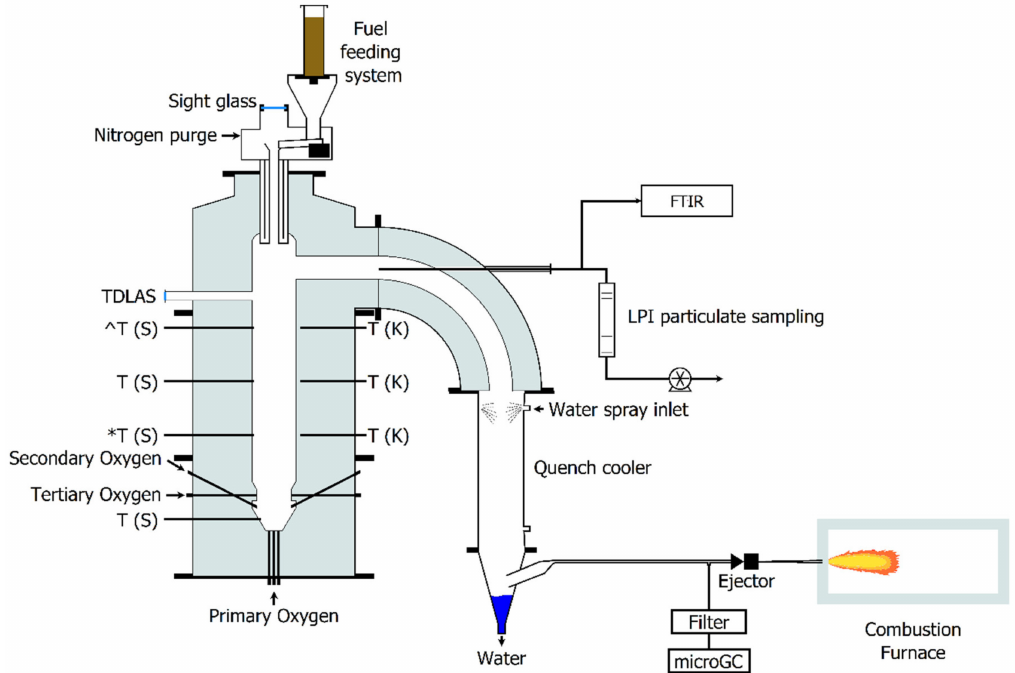
Figure 1. Schematic process flow diagram of the fixed-bed oxygen blown gasifier (FOXBG). For process temperature, reference is made to measurements at the thermocouple *T (S), while temperature measurements with tunable diode laser absorption spectroscopy (TDLAS) were compared with top thermocouple, ˆT